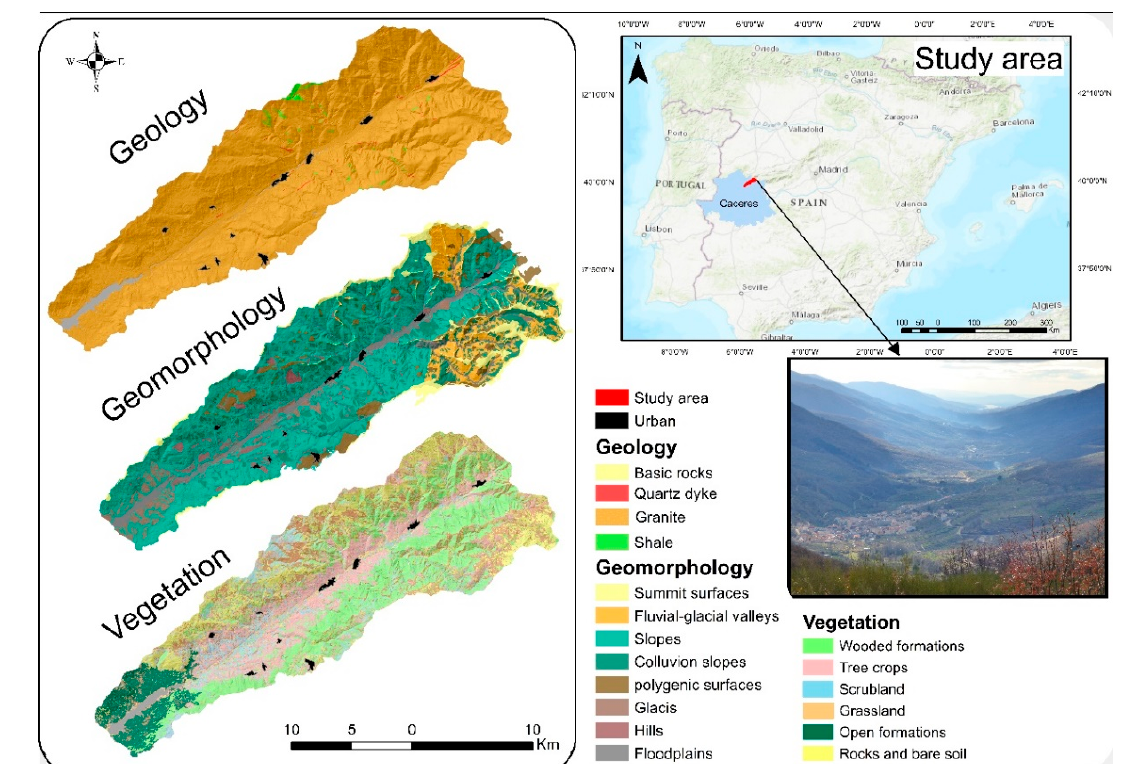
Figure 1. Study area.